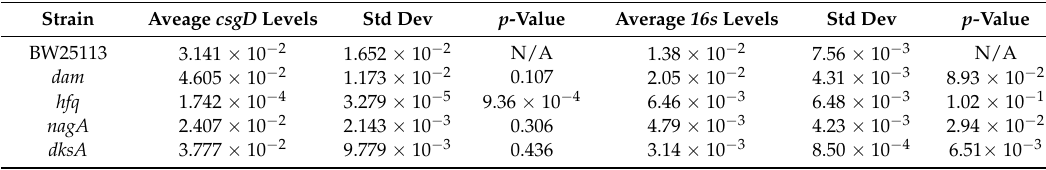
Table 4. csgD levels altered by decreased ribosome RNA